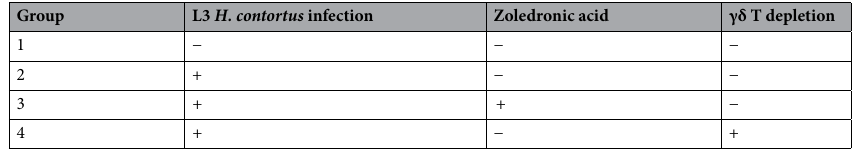
Table 2. Experimental set-up. Treatment Group (1–4) for infection L3 H. contortus (+) or non-infection H. contortus (−), with (+) or without (−) treatment type (Zoledronic acid (ZA) injection or γδ T depletion